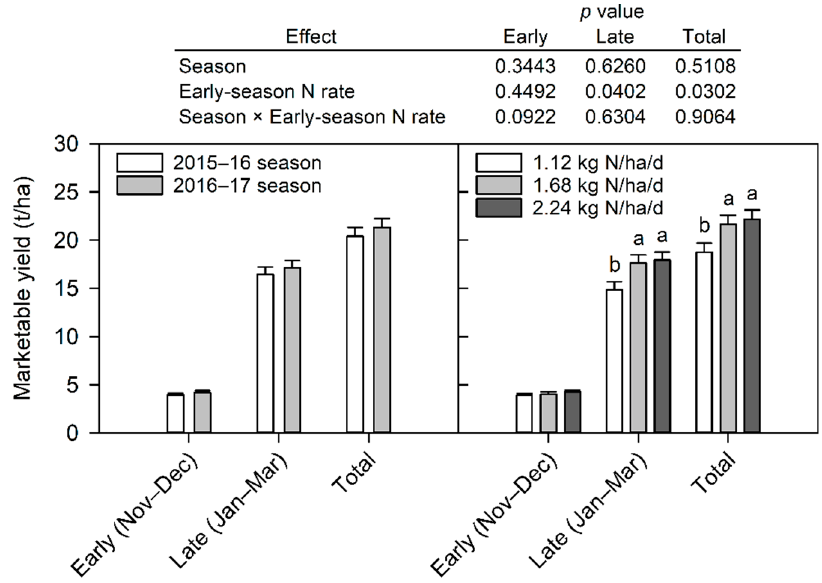
Figure 1. Marketable yield of ‘Florida Radiance’ strawberry as affected by seasons and early-season nitrogen (N) fertilization rates. Fertilization treatments are as described in Table 1. November to December and January to March harvests were classified as early and late season yields, respectively. Data are means ± SE. Data were pooled by each main effect, as they were not significantly affected by the season × early season N rate interaction ( p > 0.05). Within each yield group, bars followed with the same letter are not significantly different (Tukey–Kramer test, p ≤ 0.05).